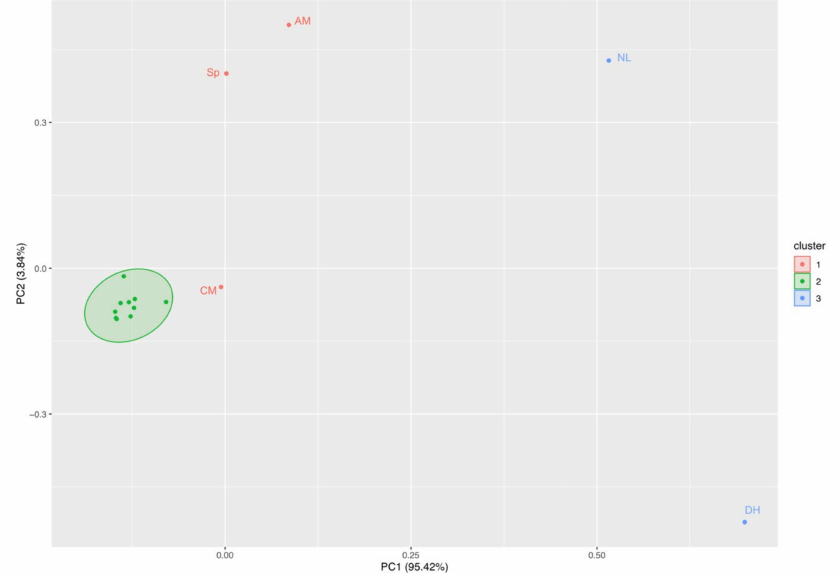
Figure 6. Principal component analysis of freshwater phytoplankton abundance across